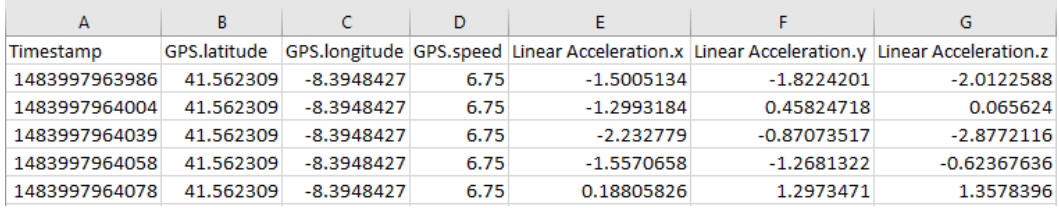
Figure 1. Collected data